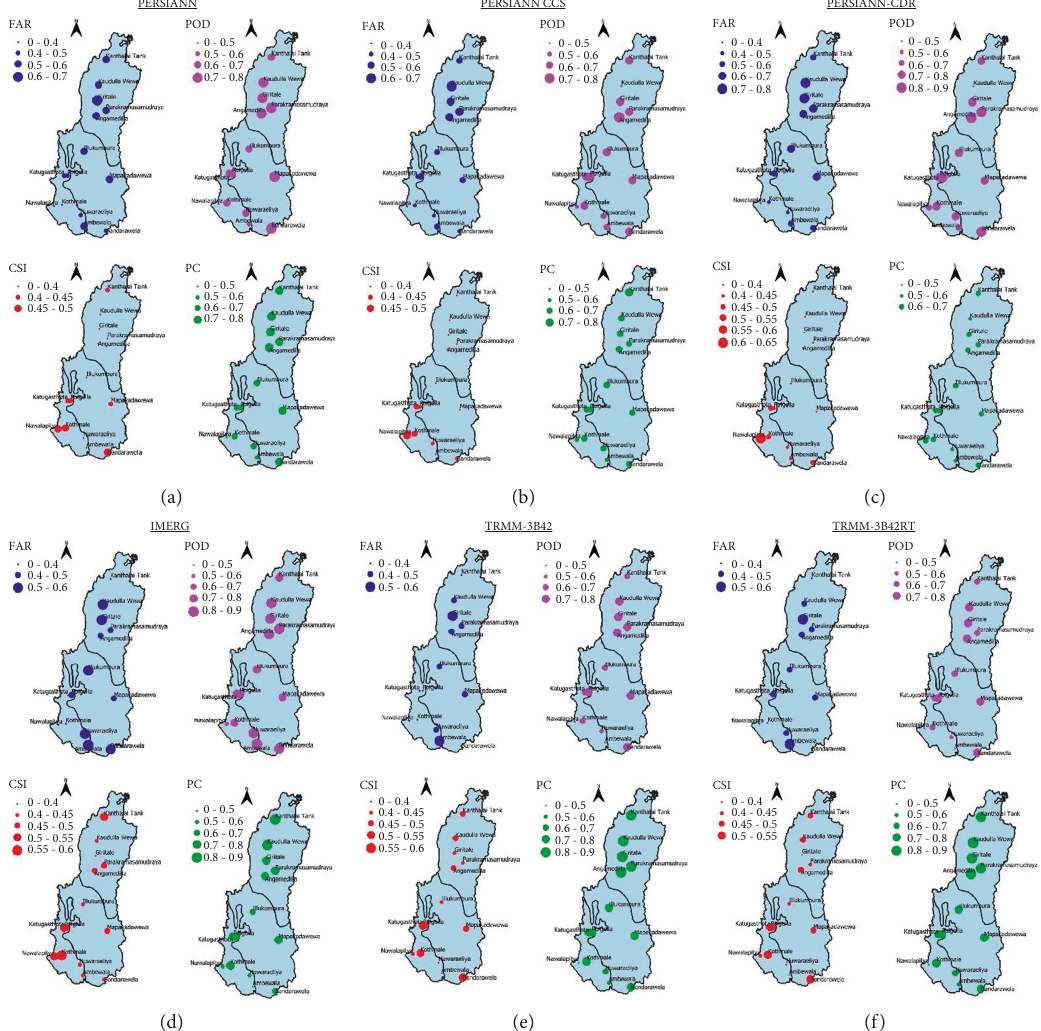
Figure 3: Categorical evaluation for light rainfall events. (a) For PERSIANN. (b) For PERSIANN-CCS. (c) For PERSIANN-CDR. (d) For IMERG. (e) For TRMM-3B42. (f) For